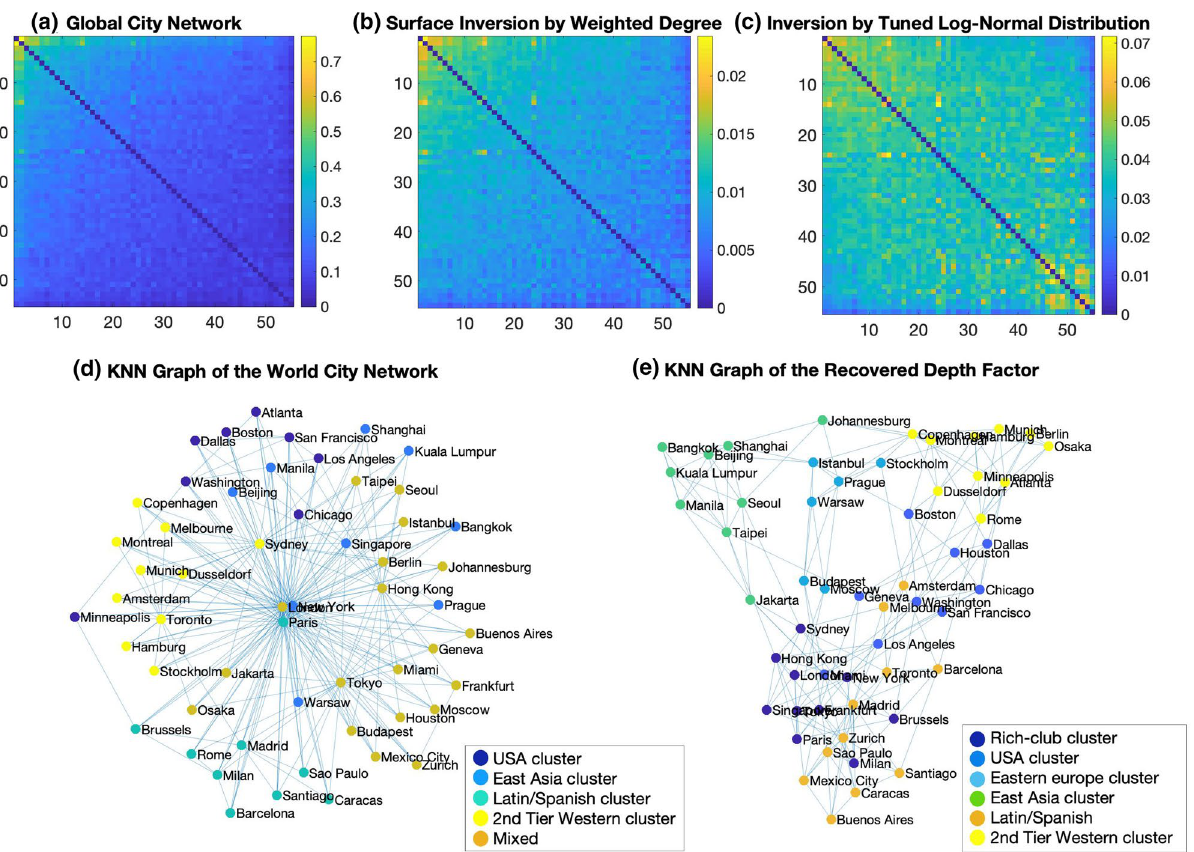
Figure 4. ( a ) Weighted adjacency matrices (ordered by weighted degree) of the global city network, ( b ) an estimated depth factor of the network using the weighted degree and ( c ) an estimated depth factor using a tuned log-normal distribution, respectively. Both axes here represent the rows and columns of the adjacency matrix. ( d ) Plot of the five-nearest neighbours graph of the world city network (left) and ( e ) its recovered depth factor (right) with detected modules shown in different colours. Modules in the depth factor are observably more distinguishable from the shape of the network, whereas relationships between the nodes in the original network are dominated by a few